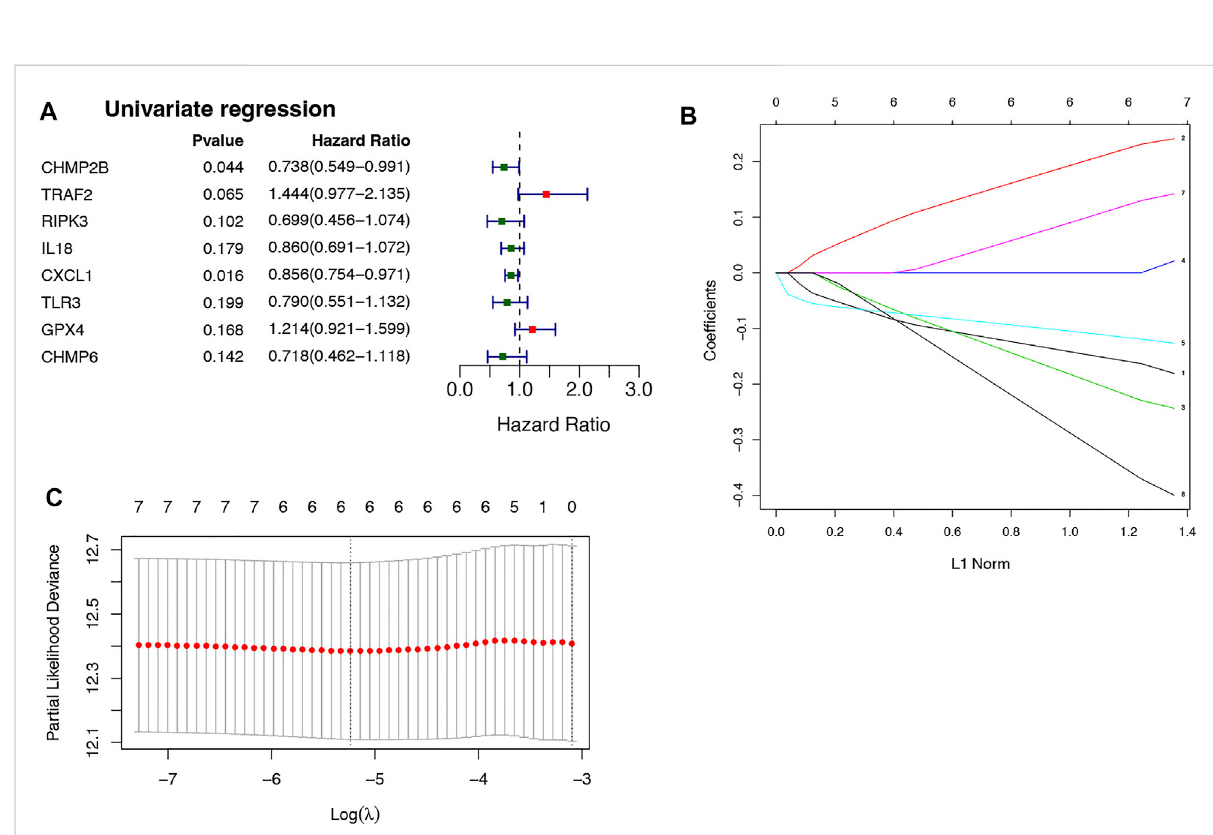
FIGURE 2 Selection of necroptosis-related genes in CRC. (A) 8 DENRGs selected based on the univariate Cox regression analysis. (B) The LASSO Cox analysis screened six genes. (C) The optimal values of the penalty parameter were de fi ned by 10 fold cross-validation. The two dotted lines representedtwoparticularvaluesof λ .Theleftsidewas λ minandtherightsidewas λ 1se.The λ minwasselectedtobuildthemodelforaccuracyinour